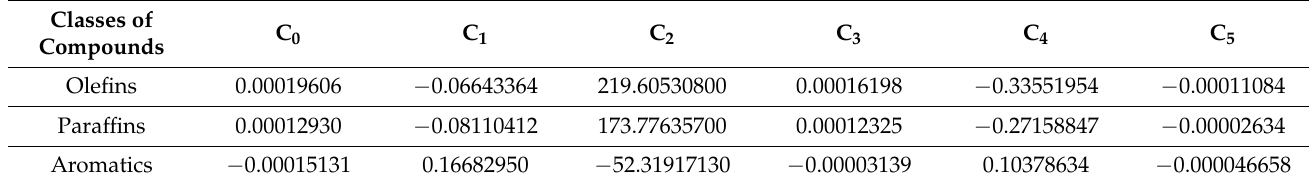
Table 1. Correlation constants for predicting the composition of all classes of compounds present in Kukersite shale gasoline fractions.